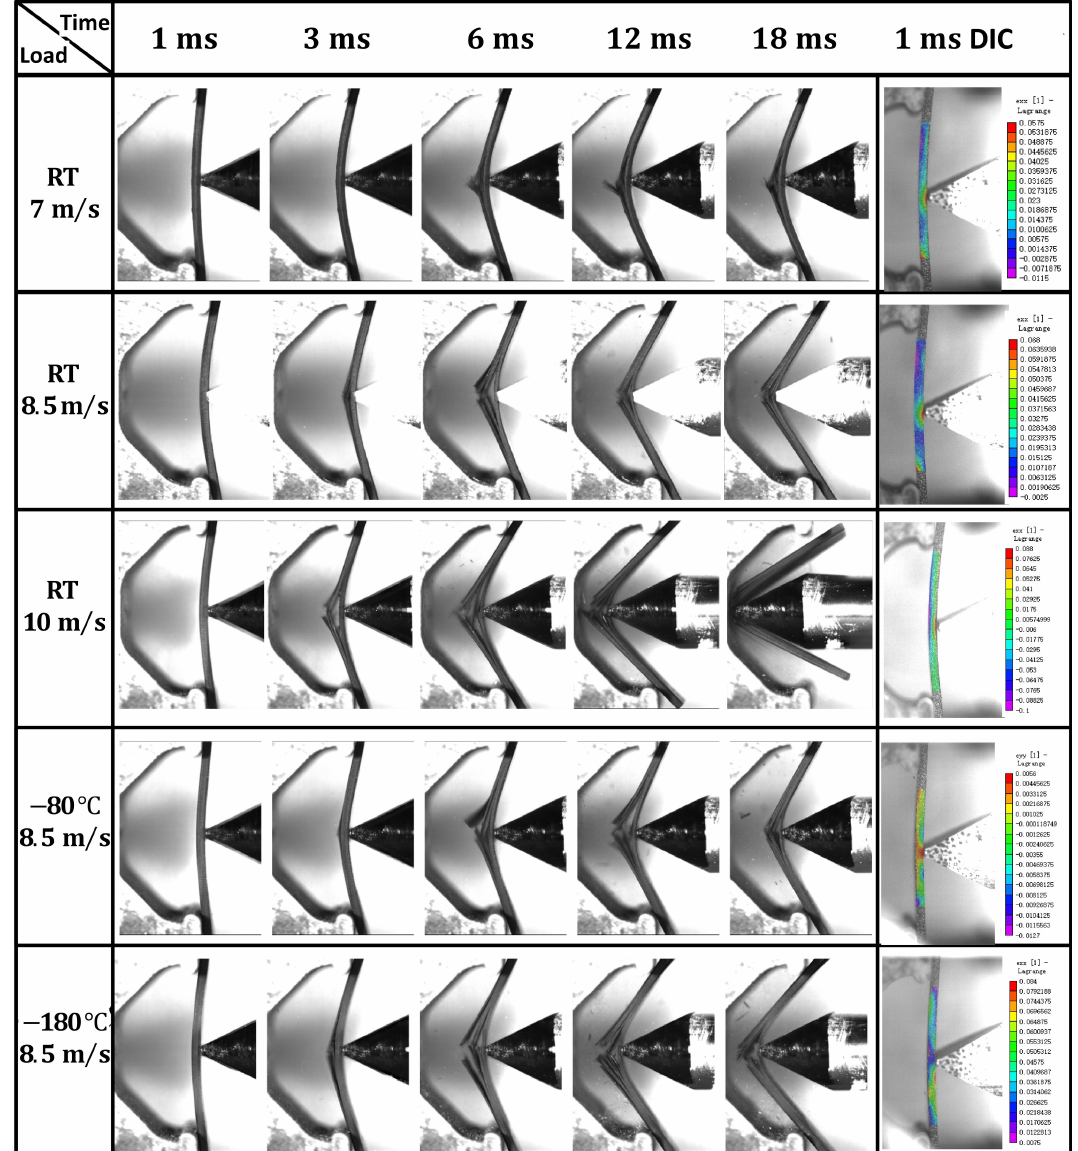
Figure 9. The damage evolution process captured by high-speed camera of the dynamic bending samples of CFRP laminates at di ff erent temperatures and impact velocities.